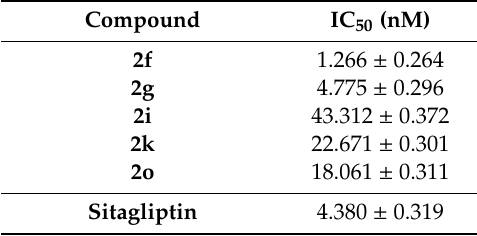
Table 2. IC 50 values of compounds 2f , 2g , 2i , 2k , and 2o for DPP-4